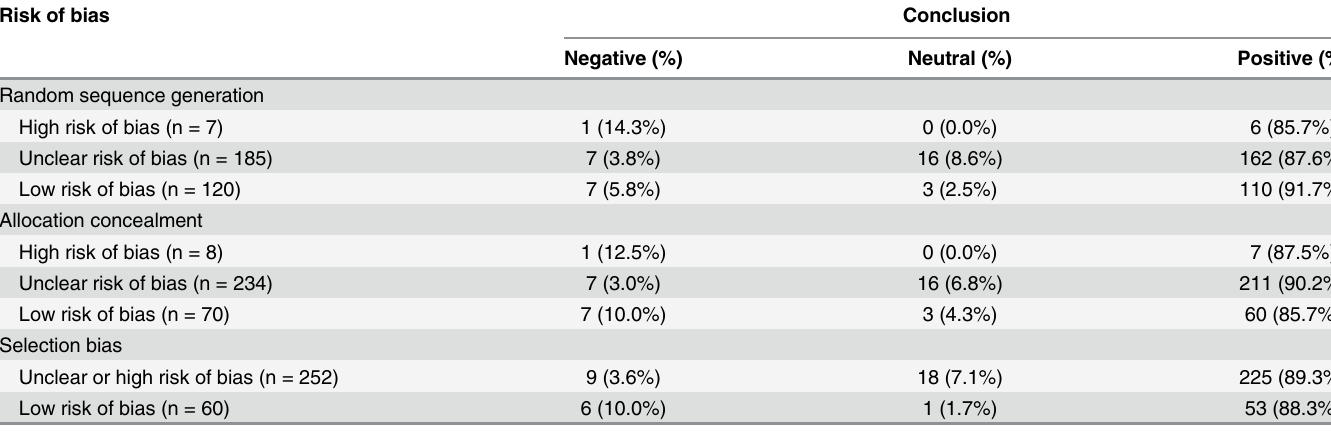
Table 3. Conclusions of the included RCTs as a function of risk of selection